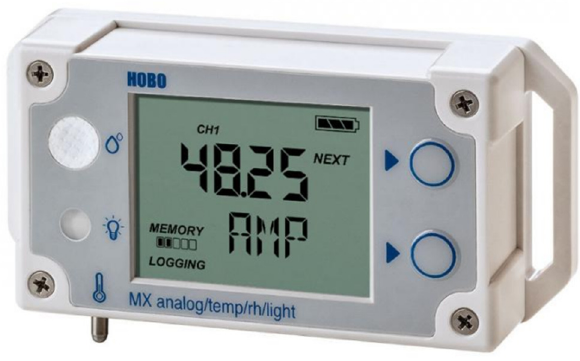
Figure 1. HOBO MX Temp/RH/Light/Ext-Temp Kit.